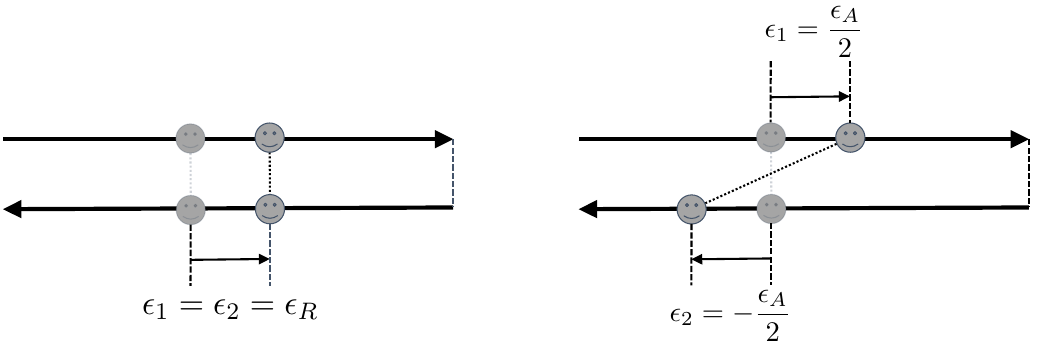
Figure 2 . (cid:15) R and (cid:15) A transformations on the closed time path. (cid:15) R translates the a = 1 ; 2 variables in the same direction while (cid:15) A does in the opposite directions. Lagrangians without explicit t dependence is invariant under (cid:15) R translations only. As depicted in the right panel, equal-time 1-2 couplings are not equal-time anymore after the (cid:15) A